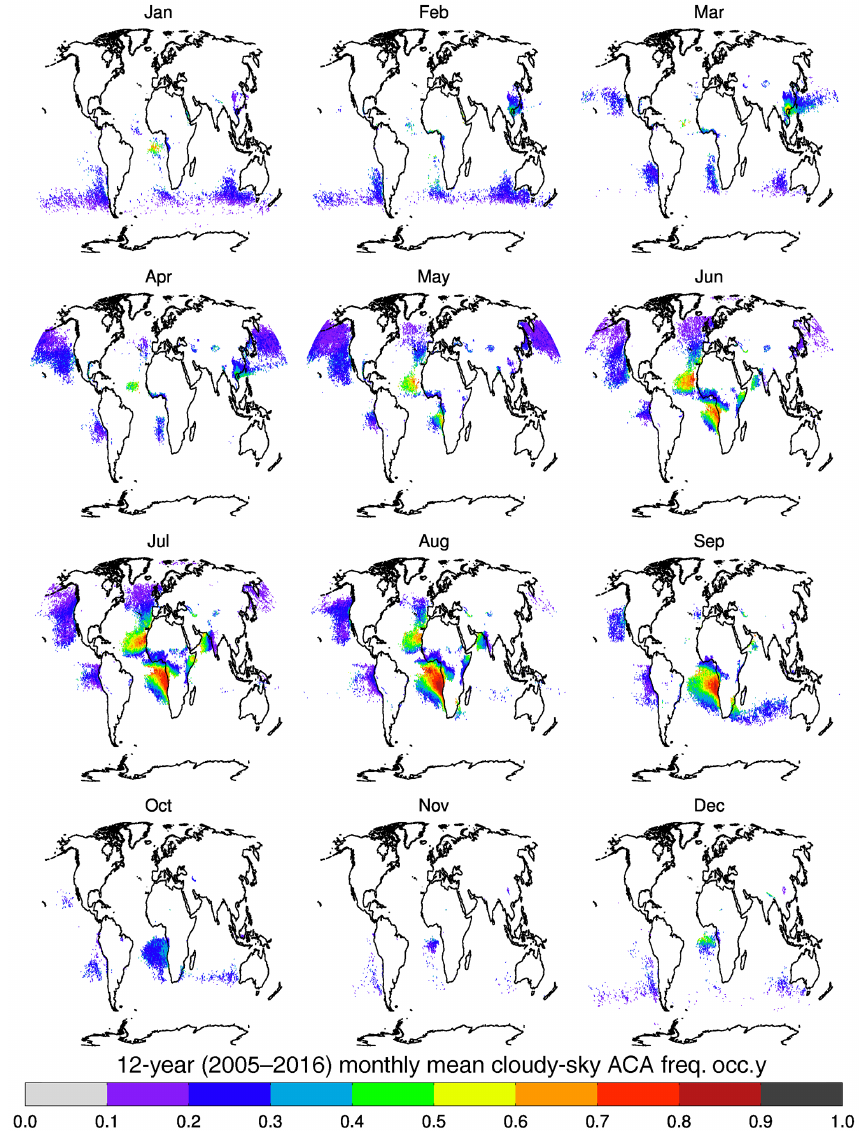
Figure 5. The monthly mean distribution of cloudy-sky frequency of occurrence of above-cloud absorbing aerosols deduced from the 12-year record (2005–2016) of OMI’s near-UV